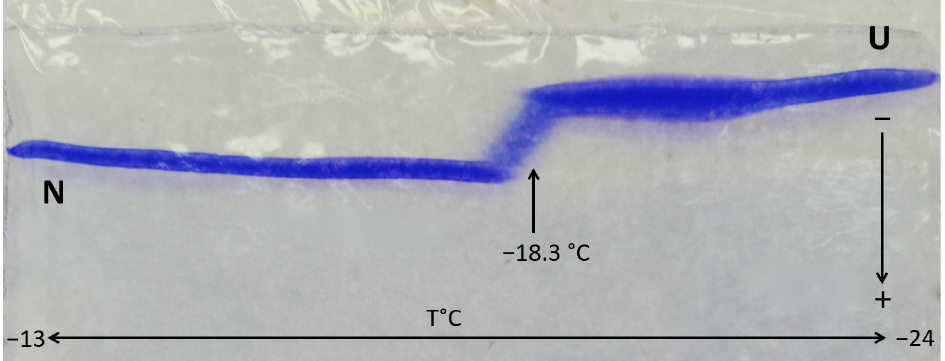
Figure 9. Subzero TTGGE of RNase A (0.68 mg/mL) between − 13° and − 24 °C. Electrophoresis was carried out for 3 days under 1800 V and 3 mA. The applied electric field was 130 V/cm. The protein was stained with Coomassie Brilliant Blue (for technical details, see [219] ). The discontinuity of the transition curve around − 18.4 °C reflects a slow transition between the N and U states as predicted when the rates of unfolding and refolding are slow [186] .